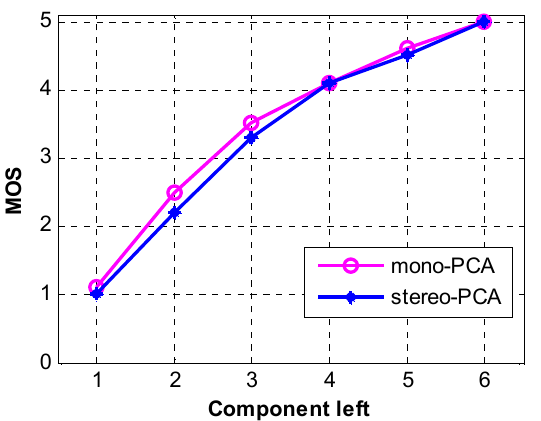
Figure 14. Subjective MOS of high-relation stereo signal. (MOS, Mean Opinion Score).